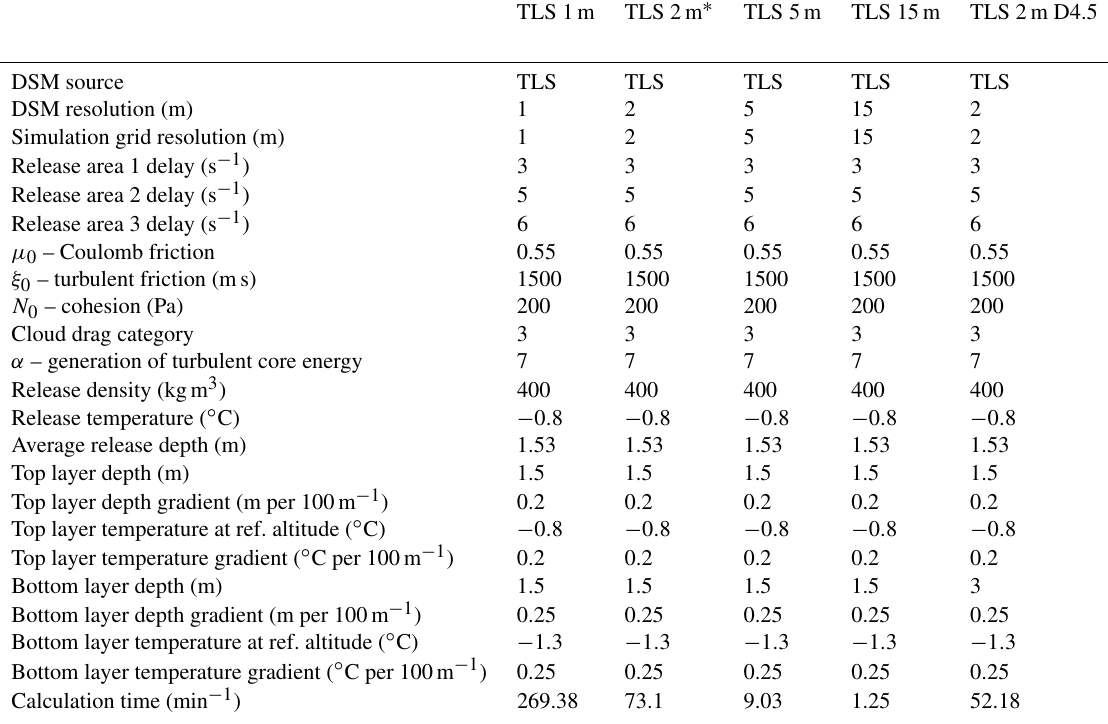
Table A1. RAMMS simulations performed with DSMs derived from terrestrial laser scanning (TLS) for the McPherson avalanche. The TLS 2m simulation was the calibrated reference simulation based on event documentation. The friction and entrainment parameters were held constant for each simulation, with the exception of TLS 2m D4.5, which increased the bottom layer snow depth to simulate additional snow available for entrainment in the path. The release area delays are based on time from explosive charge